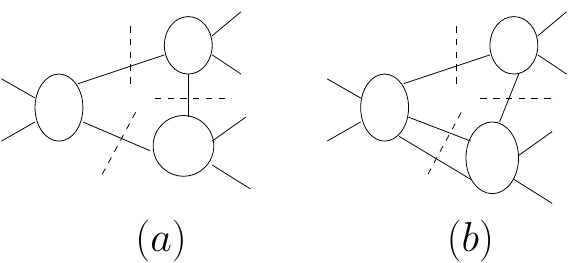
Figure 4 . Examples of eq. (6.9) for discontinuities involving: (a) three (anomalous threshold); and (b) four Cutkosky cuts (on-shell